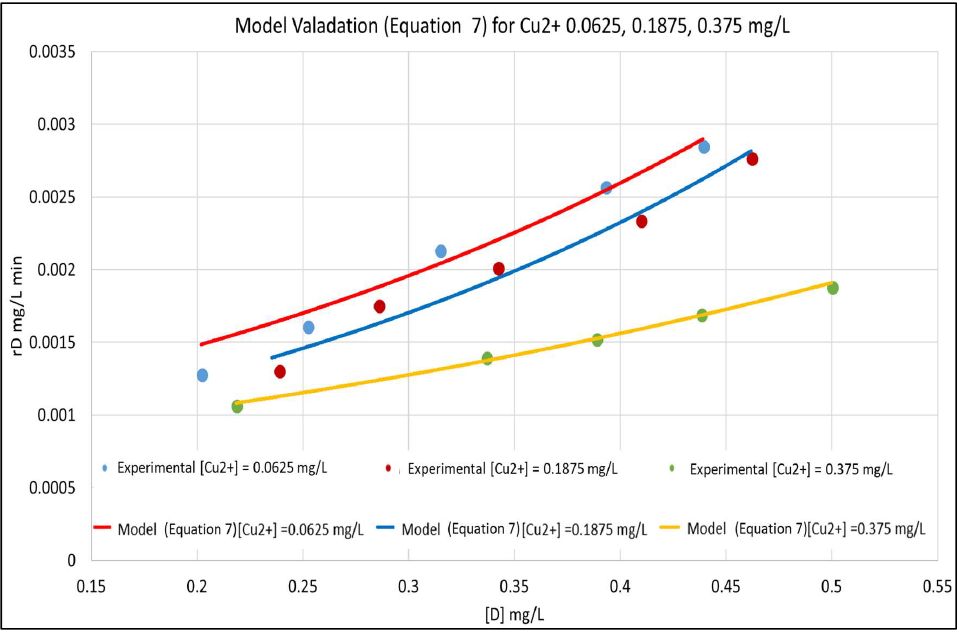
Figure 3 . Model Validation for [Cu 2+ ]: 0.0625, 0.1875, and 0.375 mg/L.